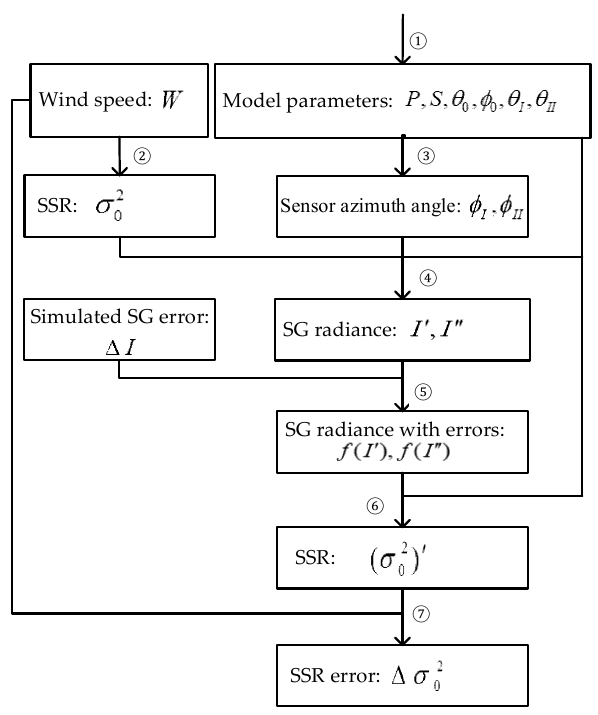
Figure 2. Error transfer simulation model.